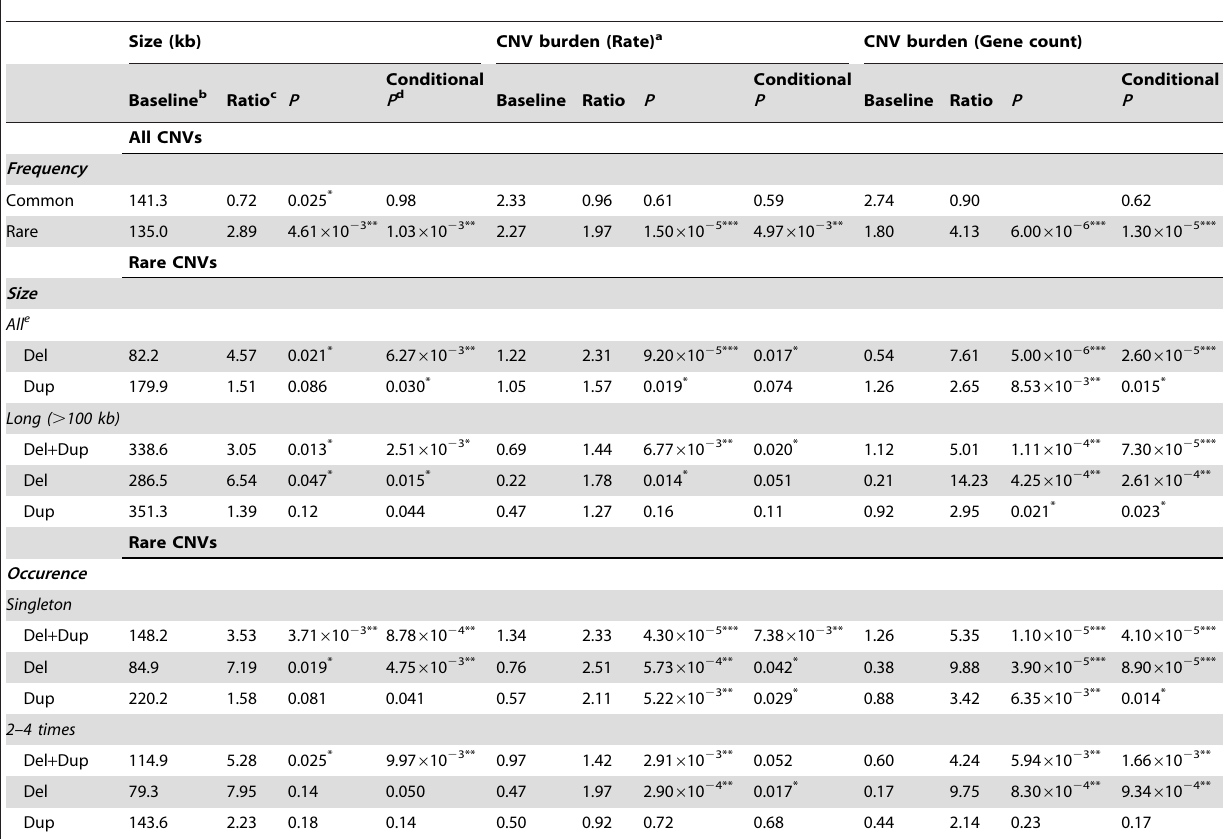
Table 1. Global CNV burden in HSCR